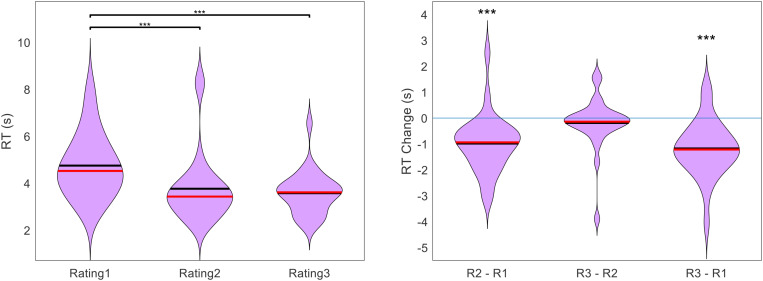
Across participants, RT (across items) decreased with each additional rating. Figure shows the cross-participant mean of within-participant mean RT across trials, separate for each rating task (black lines indicate means, red lines indicate medians, significance stars indicate: ***p < 0.001).